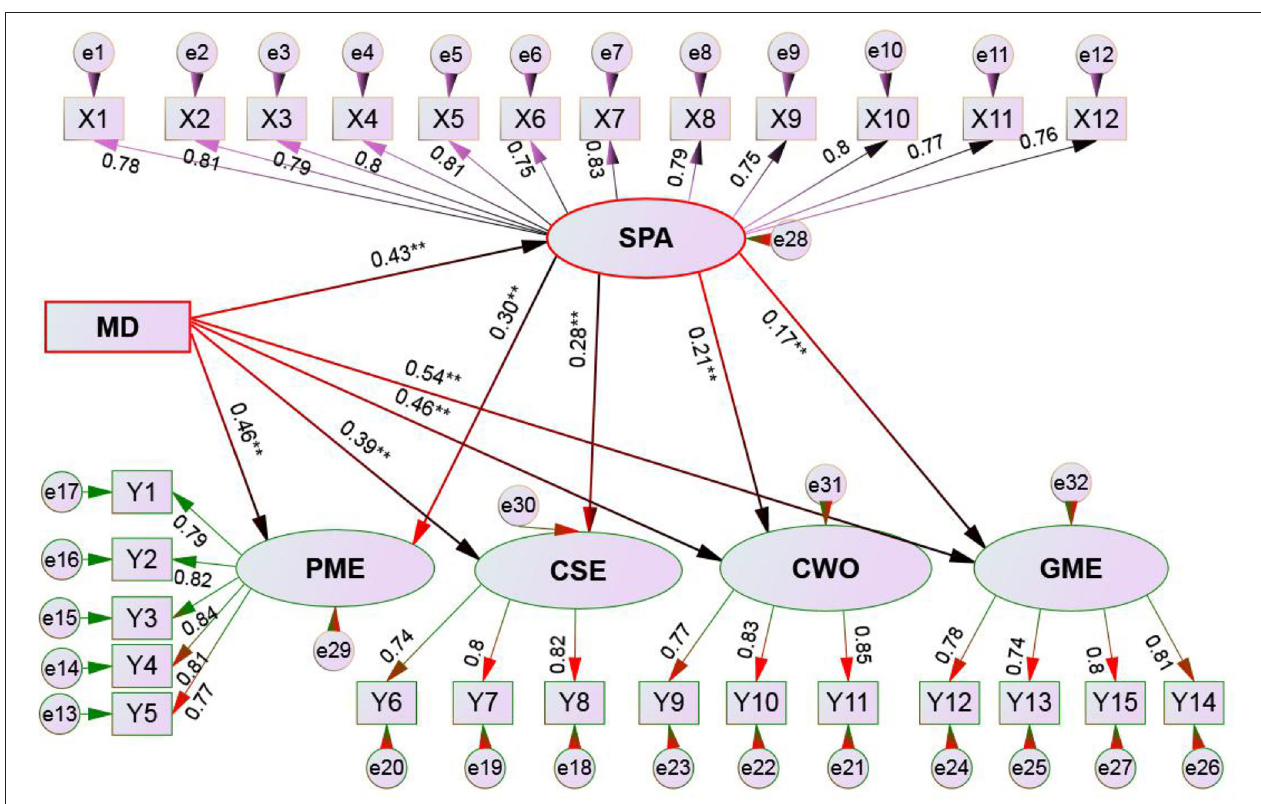
FIGURE 1 | Structural Equation model schematic of muscle dysmorphia, social physique anxiety, and body checking behaviors. MD, muscle dysmorphia; SPA, social physique anxiety; GME, global muscle checking; CSE, chest and shoulder muscle checking; CWO, comparison with others; PME, posture measurement checking. ** p < 0.01.